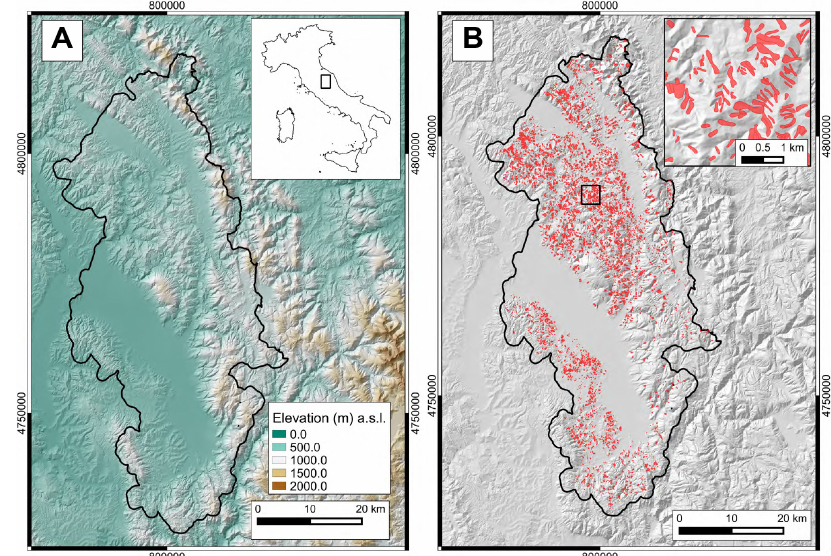
Figure 4. (a) Shaded relief image of the study area located on the upper Tiber River basin, Umbria, central Italy. Shades of green to brown show increasing elevation. Inset shows location of the study area in Italy. (b) Landslide inventory map (Cardinali et al., 2001). Inset shows the detail of the landslide mapping. Landslides (shown in red) were used to prepare the landslide susceptibility zonations shown in Fig. 10. The maps are in the UTM zone 32, datum ED50 (EPSG:23032) reference system.